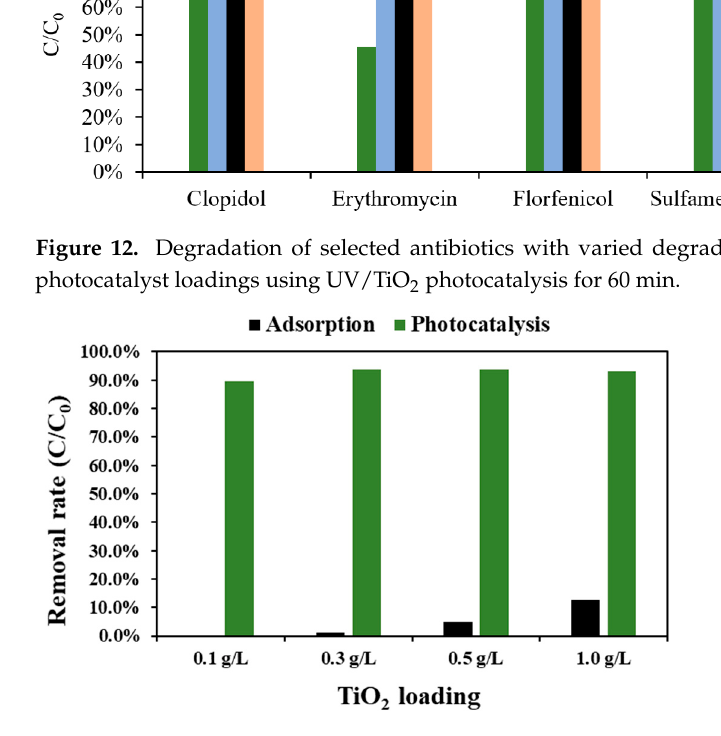
Figure 13. Removal rate of antibiotics of adsorption and photocatalysis according to TiO 2 loading.